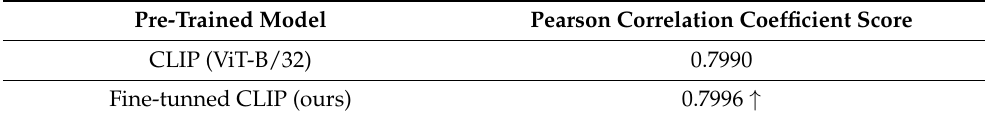
Table 6. The Pearson correlation coefficient score between HCN and CN before and after fine-tuning at 500 epochs.